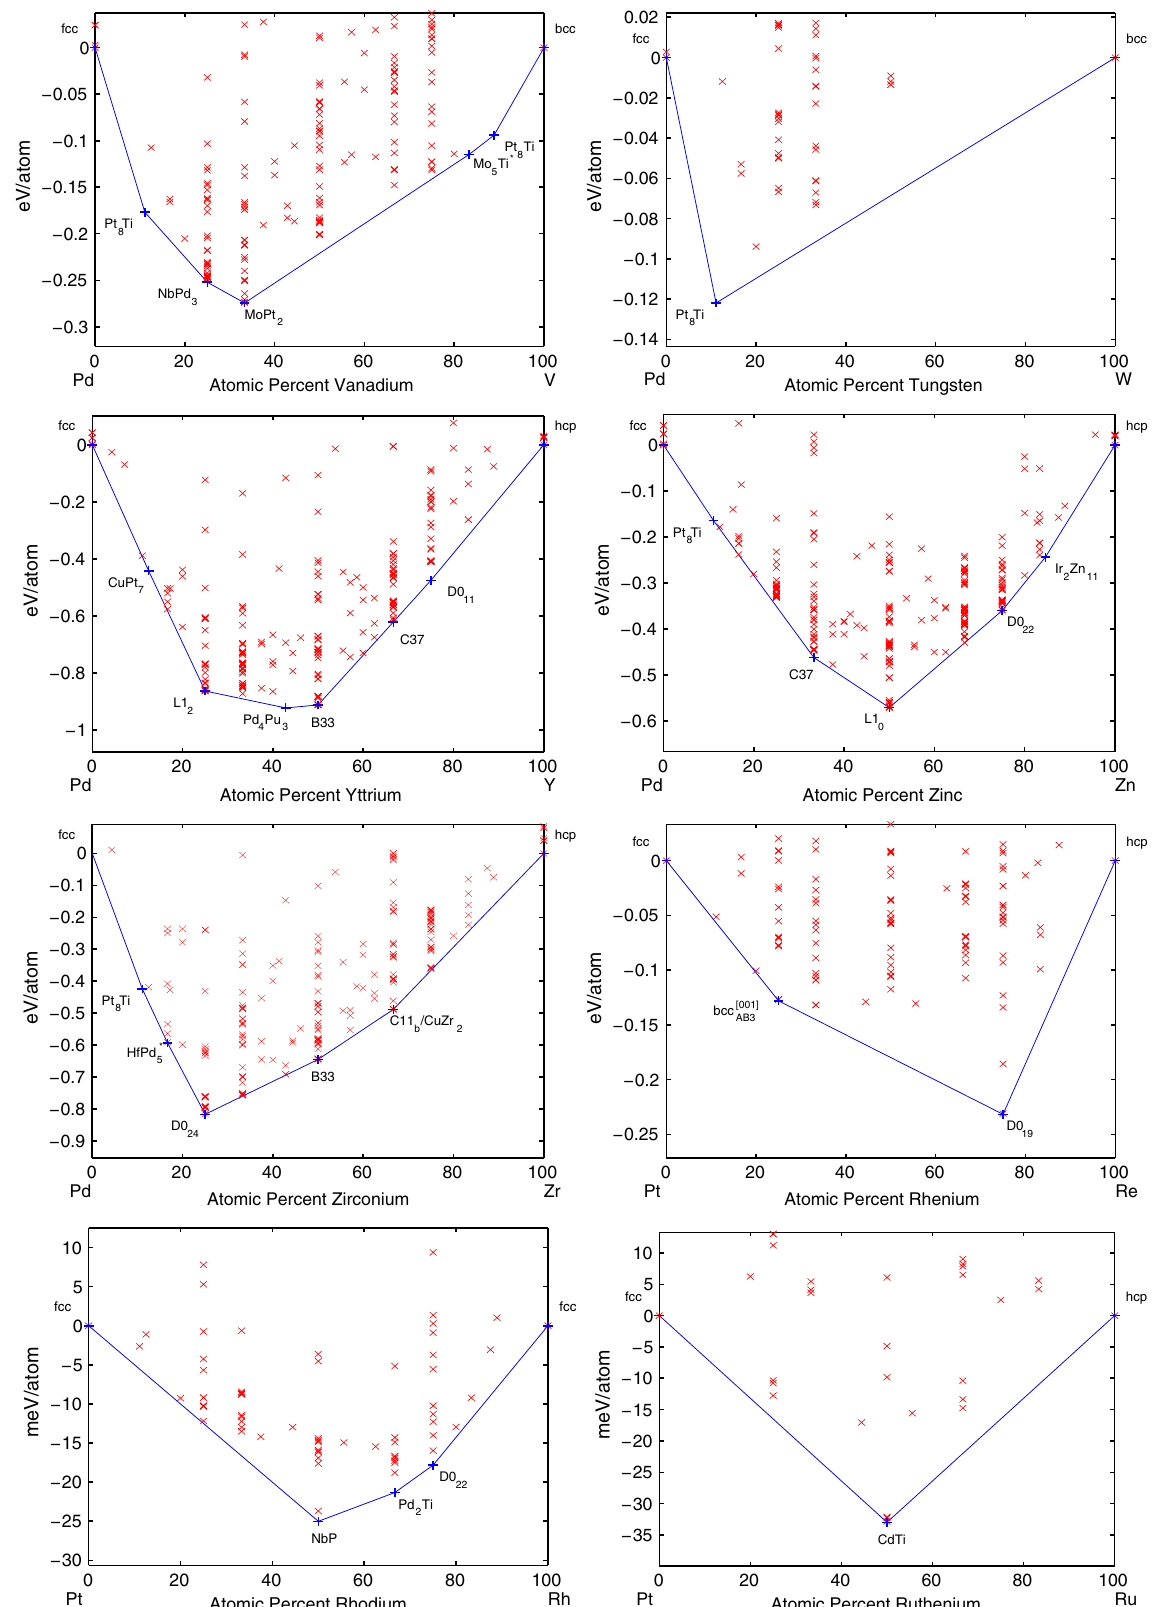
FIG. 15. Convex hulls for the systems PdV, Pd-W, Pd-Y, Pd-Zn, Pd-Zr, Pt-Re, Pt-Rh, and